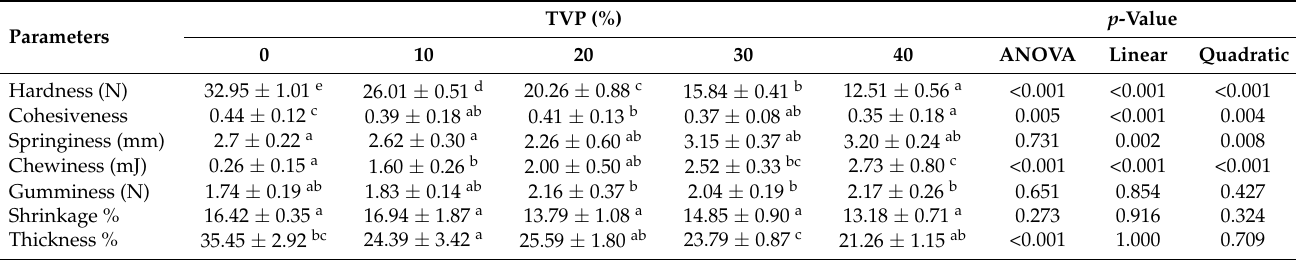
Table 4. Mechanical properties of beef patties replaced with different levels of